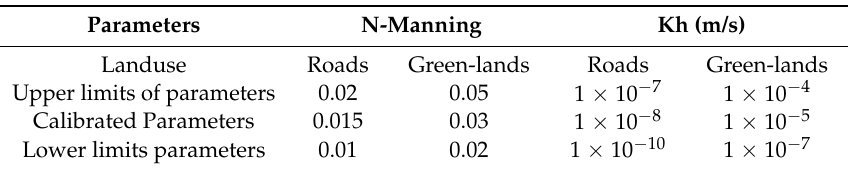
Table 3. Different configurations of saturated hydraulic conductivity (Kh) and Manning’s N coefficient for Scenario 2